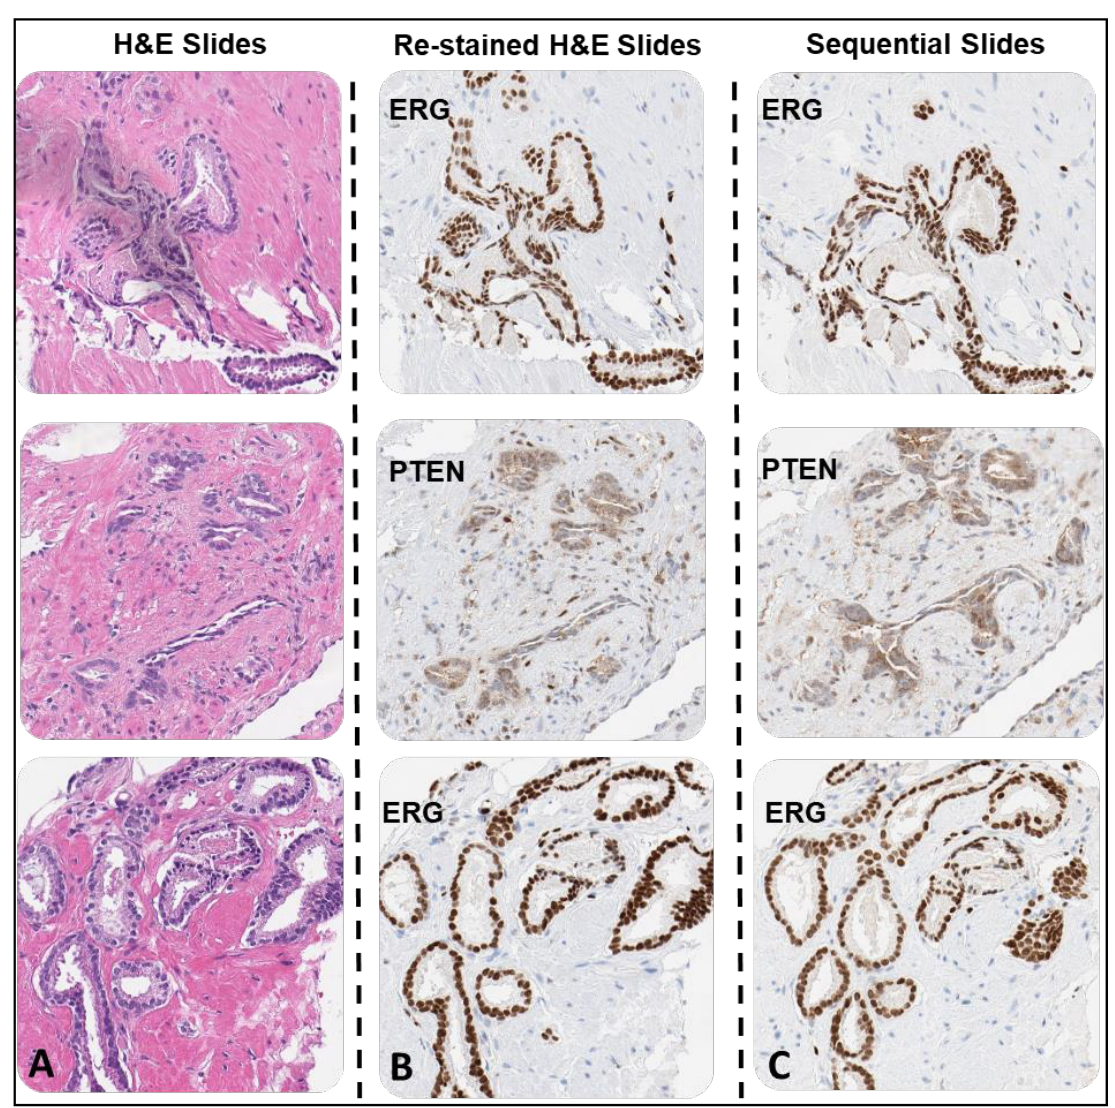
Figure 3. Prostate cancer core needle biopsies (CNBs) sample H&E slides with PTEN and ERG IHC DAB stained slides. The first slide for each sample was H&E-stained ( A ). Each sample H&E was de-